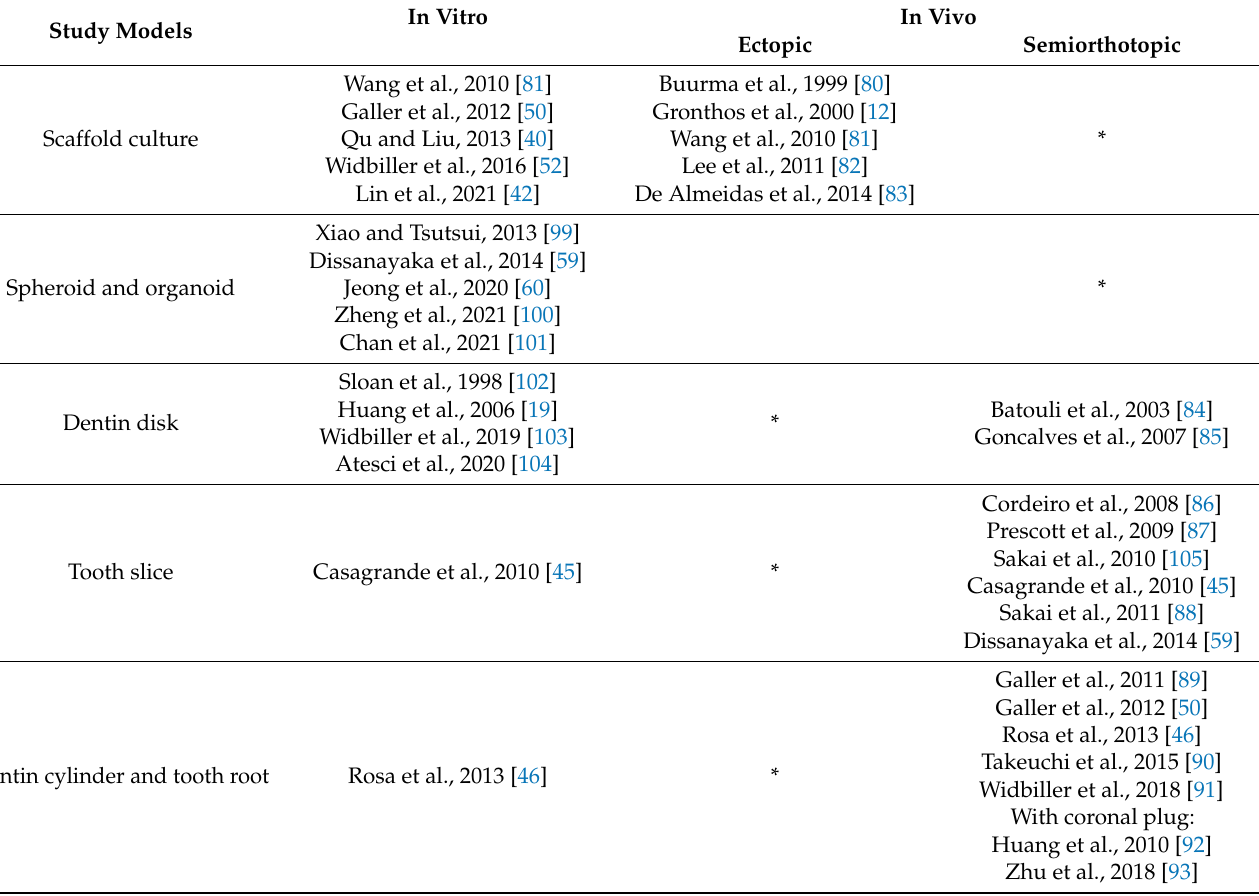
Table 2. Selected references for applications of each study model, including both in vitro and in vivo. The asterisk indicates categories that are not conceivable in the present